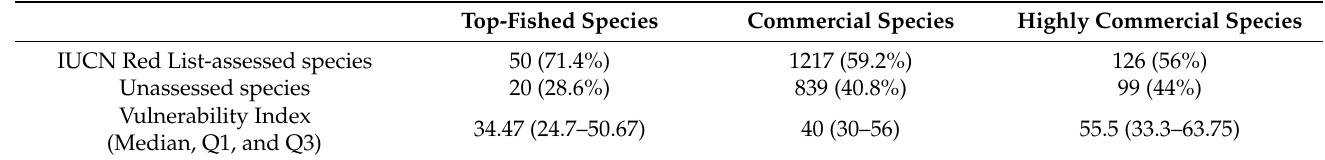
Table 1. Number and proportion of IUCN Red List-assessed and -unassessed species for each species sub-set, and their average vulnerability indices.